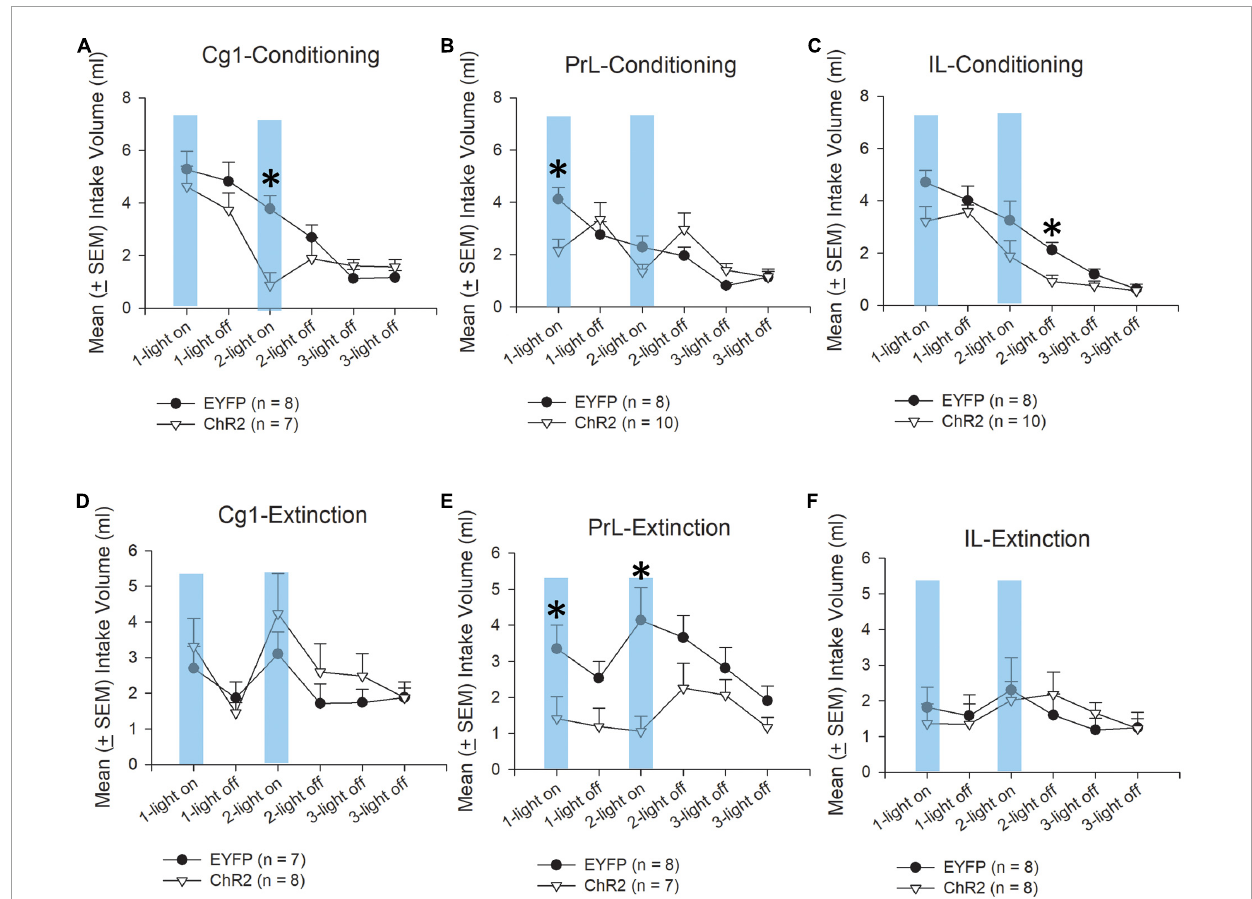
FIGURE5 Morphine acts as an aversive US in CTA. Mean ( ± SEM) intake volume of saccharin solution in rats injected with morphine under optical stimulation of the Cg1, PrL, and IL during conditioning (A–C) and extinction (D–F) , with 3-min light-on and 3-min light-off treatments occurring over two sessions and 3-min light-off and 3-min light-off treatments occurring in Session 3. In the CTA test, the rats were divided into EYFP ( n = 8) and ChR2 ( n = 7) groups. ∗ p < 0.05 indicates the ChR2 group compared with the EYFP